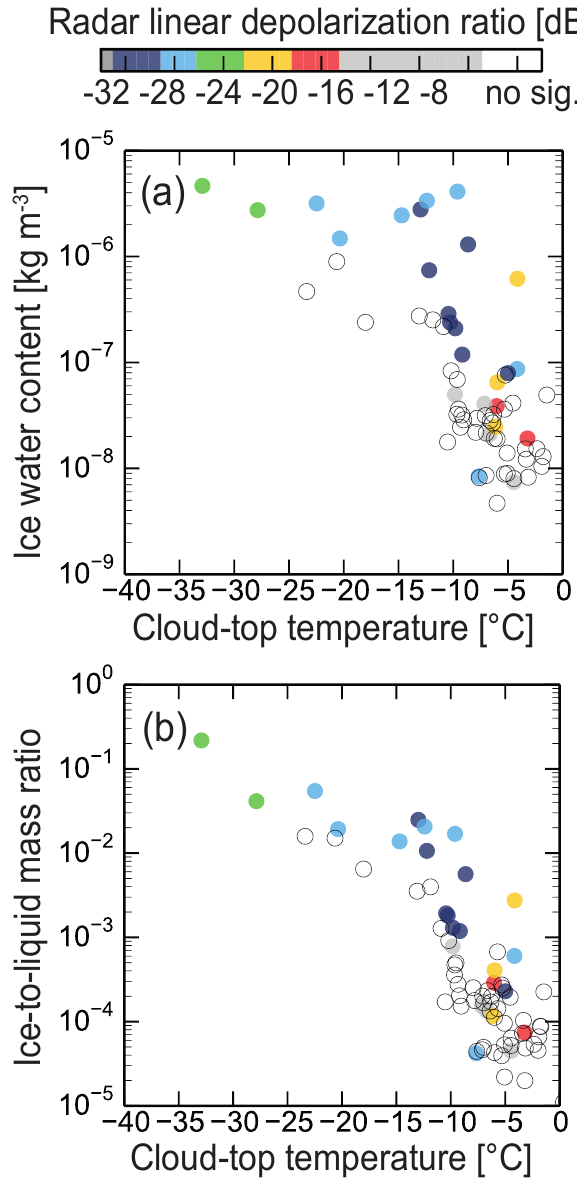
Figure 13. Relationship between mean ice water content (IWC) and ice-to-liquid mass ratio as a function of cloud-top temperature of all thin supercooled stratiform clouds detected during HOPE-Jülich. The colours represent the different radar linear depolarization ratios.